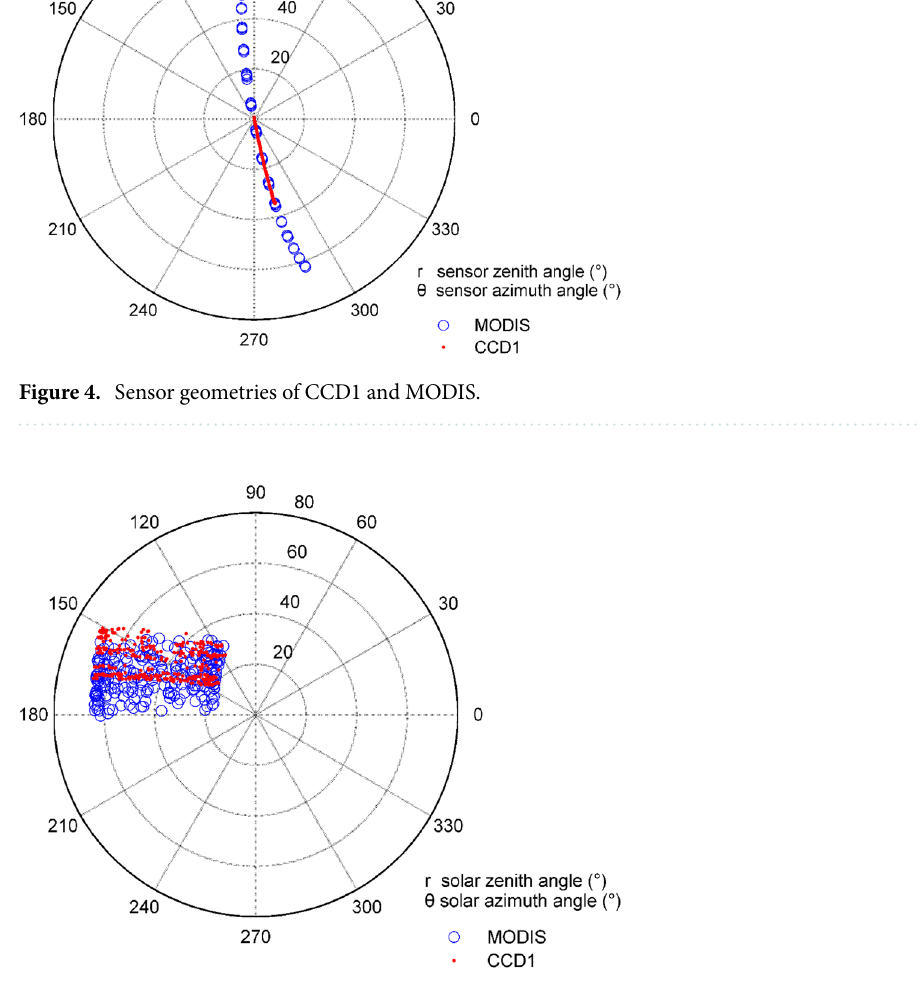
Figure 5. Solar geometries when CCD1 and MODIS